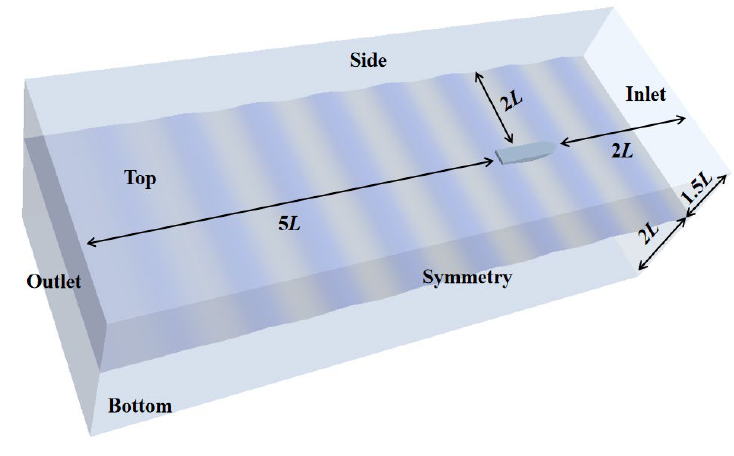
Figure 1. Sketch of the computational domain and boundaries. Table 1. Configuration of the numerical domain.